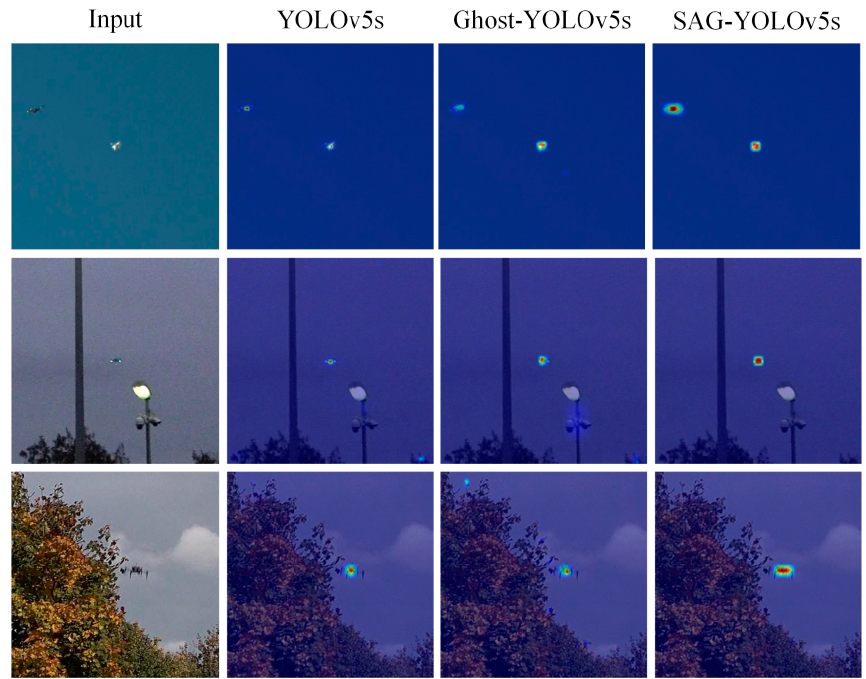
Figure 9. Visual heatmaps of different networks.